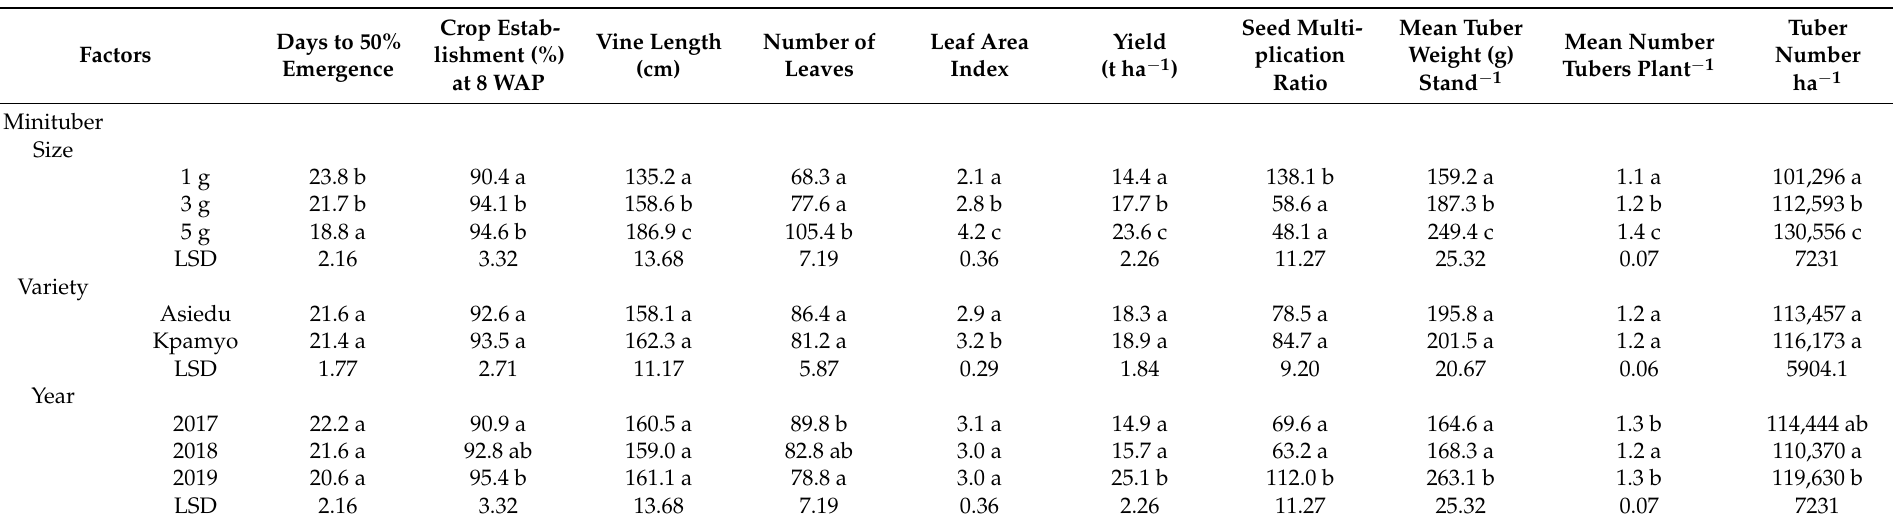
Table 1. Mean seed multiplication ratio, growth, and yield response variables of two D. rotundata Poir. varieties planted with 1, 3, and 5 g minitubers in Abuja, Nigeria during the 2017, 2018, and 2019 cropping